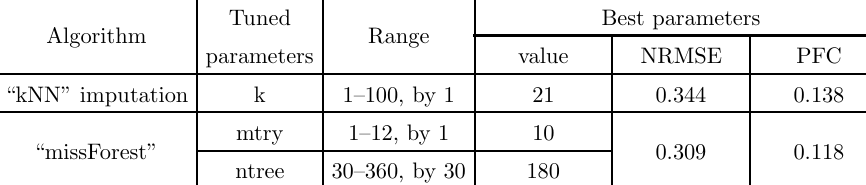
Table 4. Tuned parameter range and result of imputation algorithms